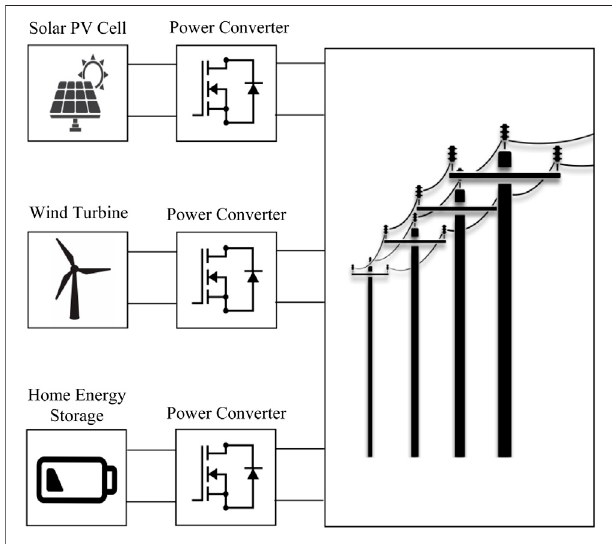
FIGURE 1 | Schematic of more-electronics power